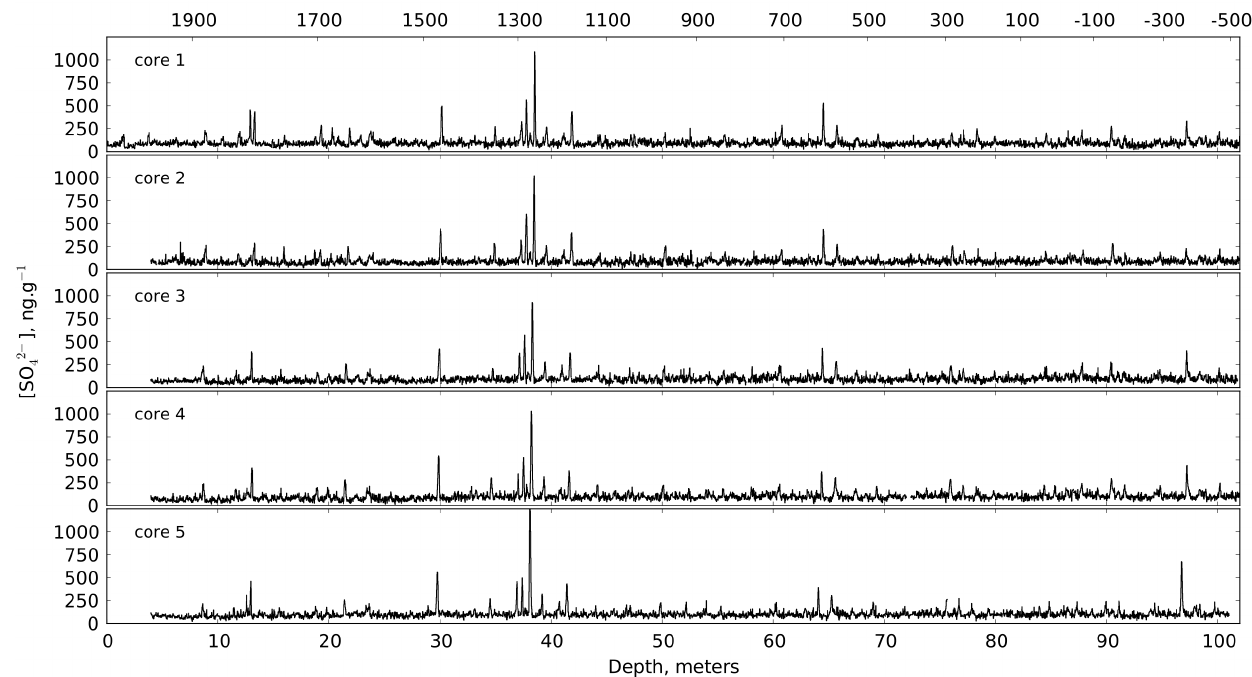
Figure 1. Sulfate profiles on the five replicate cores obtained during a drilling operation at Dome C – Antarctica in 2011. Data are available at https://www.ncdc.noaa.gov/data-access/paleoclimatology-data.